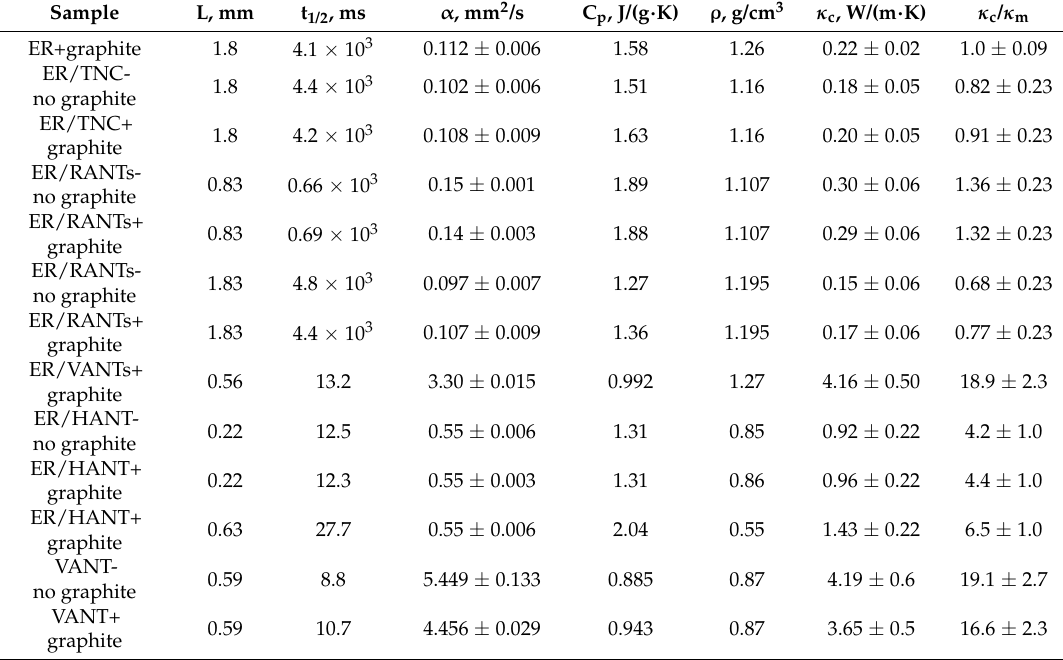
Table 1. Thermal conductivity measured for a number of epoxy resin based composites filled with different types of carbon